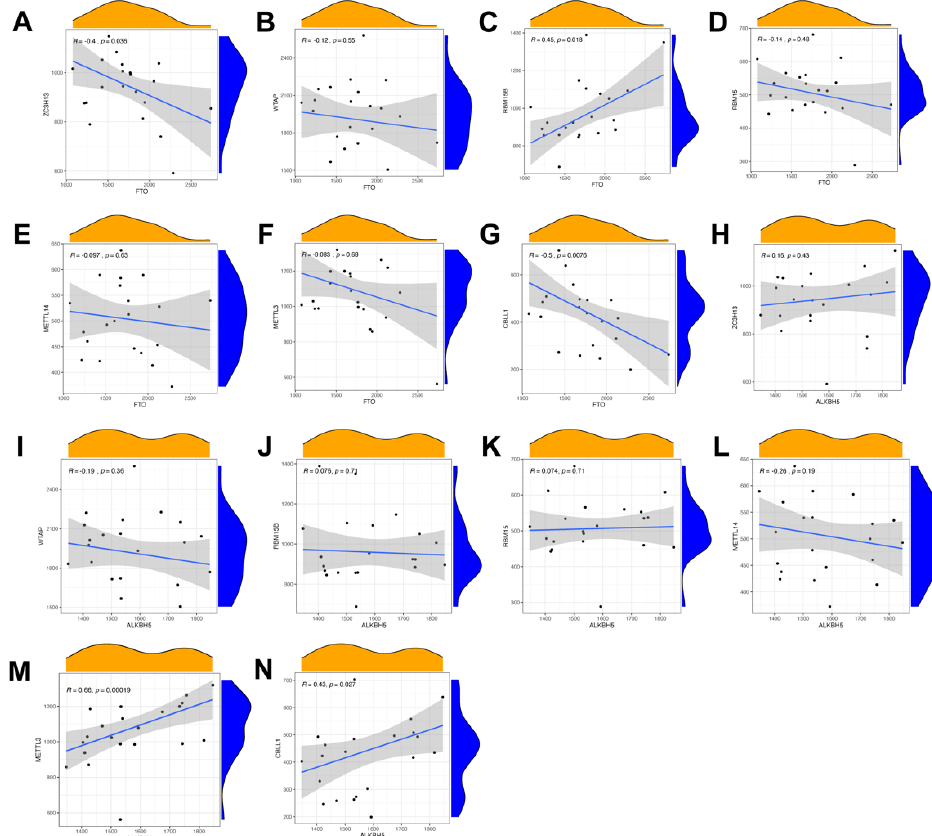
Figure 3. Correlation between erasers and writers in endometriosis. ( A – N ). Writer genes: WTAP , ZC3H13 , METTL3 , RBM15 , RBM15B , METTL14 , and CBLL1 ; eraser genes: ALKBH5 and FTO .